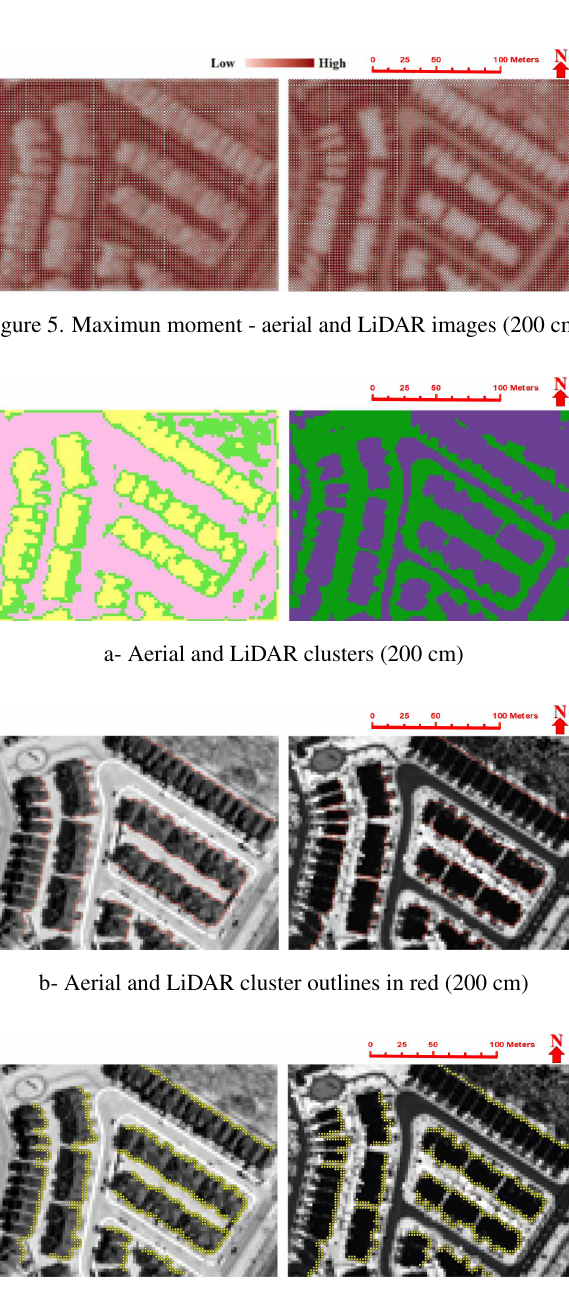
Figure 6. Scene abstraction for CCPs